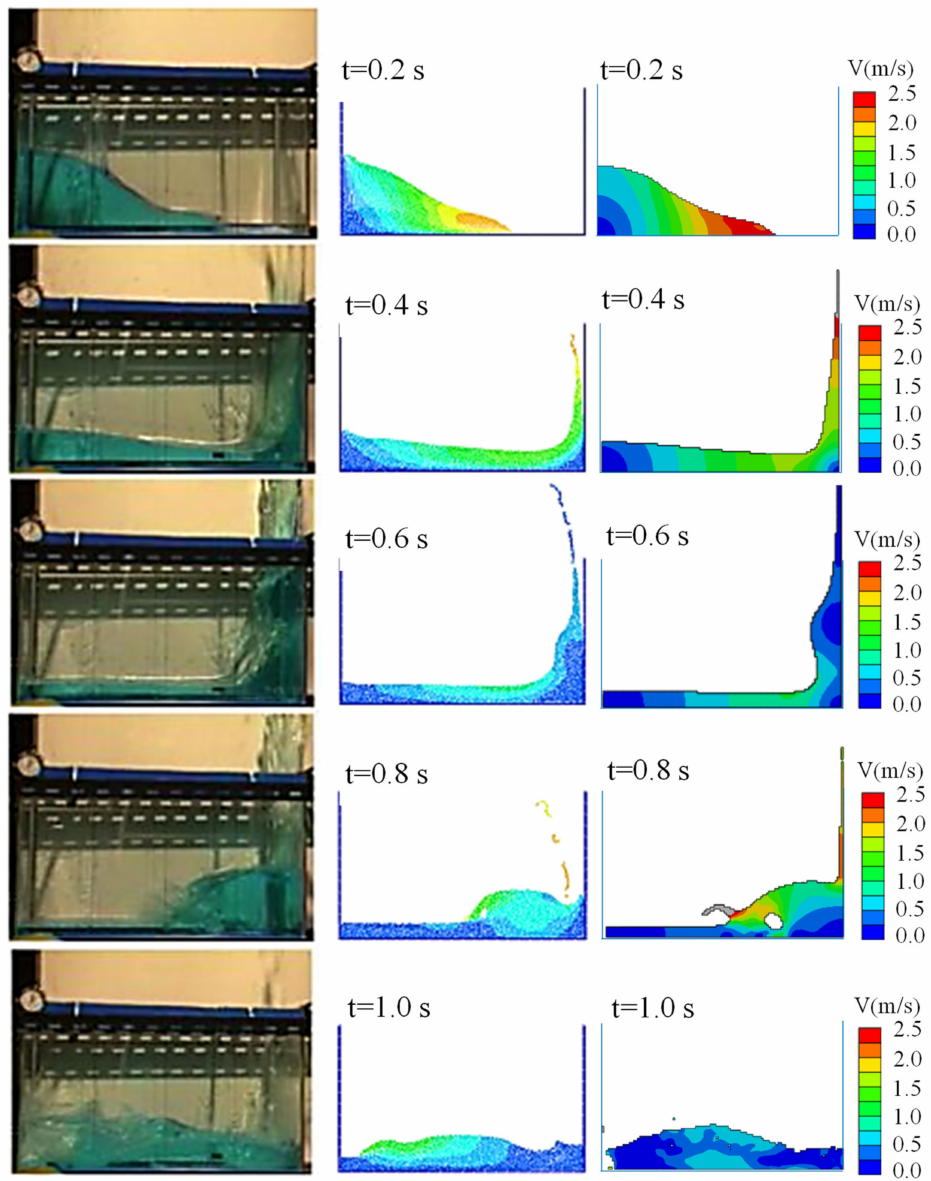
Figure 5. The process of water column collapse. Left column: the experiment. Middle column: SPH results. Right column: CEL results obtained in this